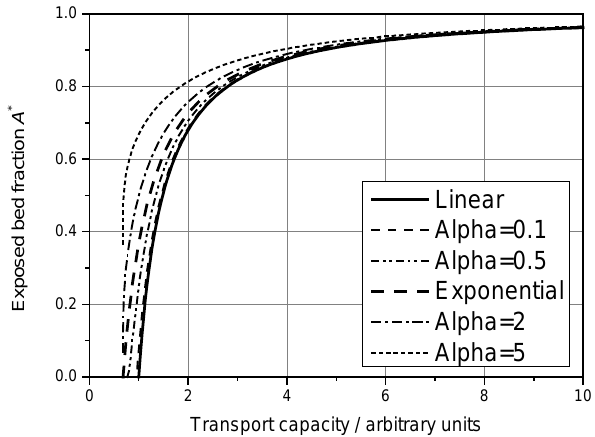
Figure 8. The characteristic dimensionless mass M ∗ critical Shields stress (Eq. 37).